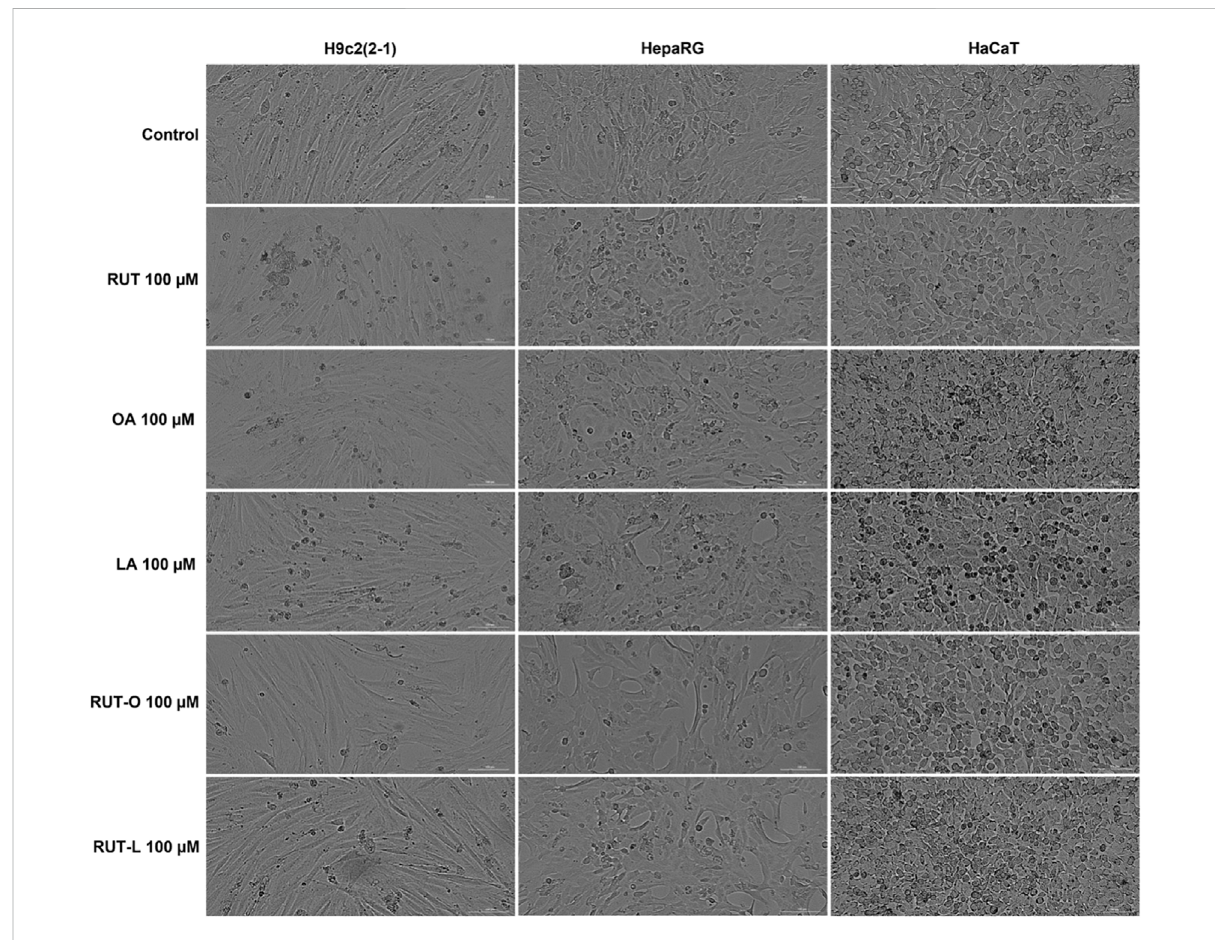
FIGURE 4 Microscopical appearance of cellular morphology and con fl uence of H9c2(2-1), HepaRG, and HaCaT cells following a 24 h treatment with the parent compounds (RUT, OA, LA), and rutin esters (RUT-O, RUT-L) at 100 µM. The scale bars represent 200